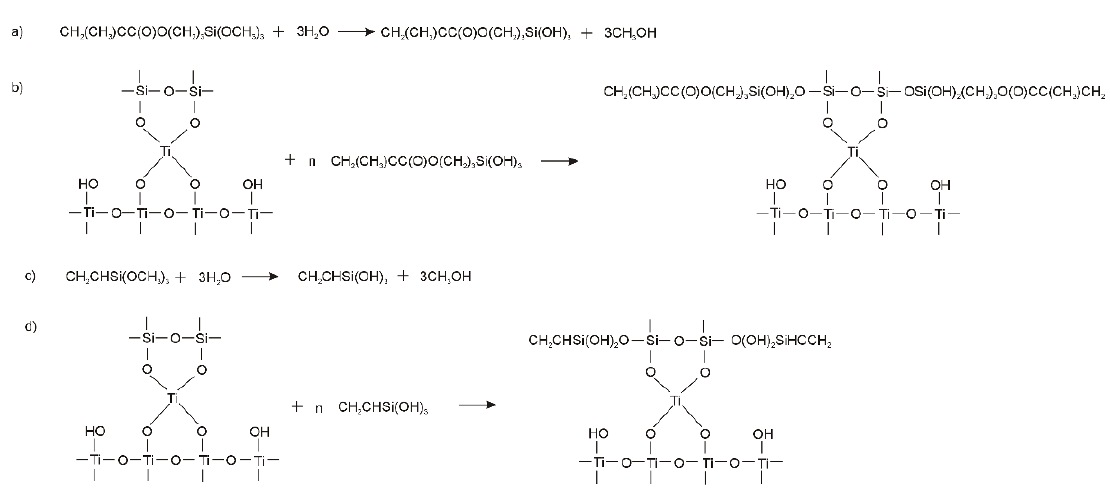
Figure 2. The TiO